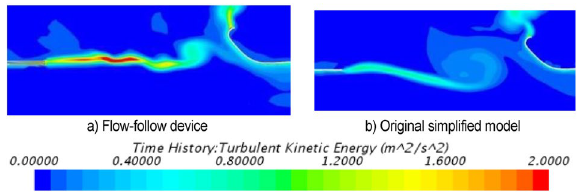
Figure 44. Cloud diagram of turbulent kinetic energy at the jet boundary.